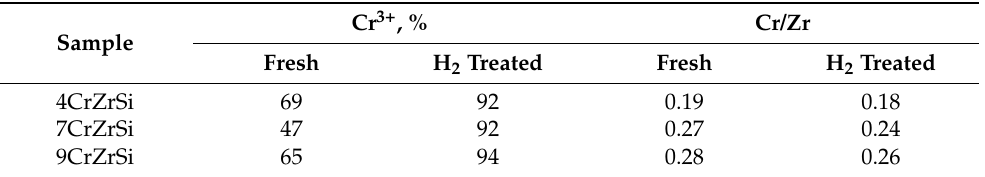
Figure 5. Cr2p XPS spectra of fresh ( a ) and hydrogen-treated ( b ) CrZrSi catalysts. Spectra were recorded in less than 100 s at the beginning of XPS experiment (immediately after X-ray gun and neutralizer were switched on). Table 2. The percentage of Cr 3+ species relative to the total Cr content and Cr/Zr molar ratio in fresh and hydrogen-treated CrZrSi catalysts determined by